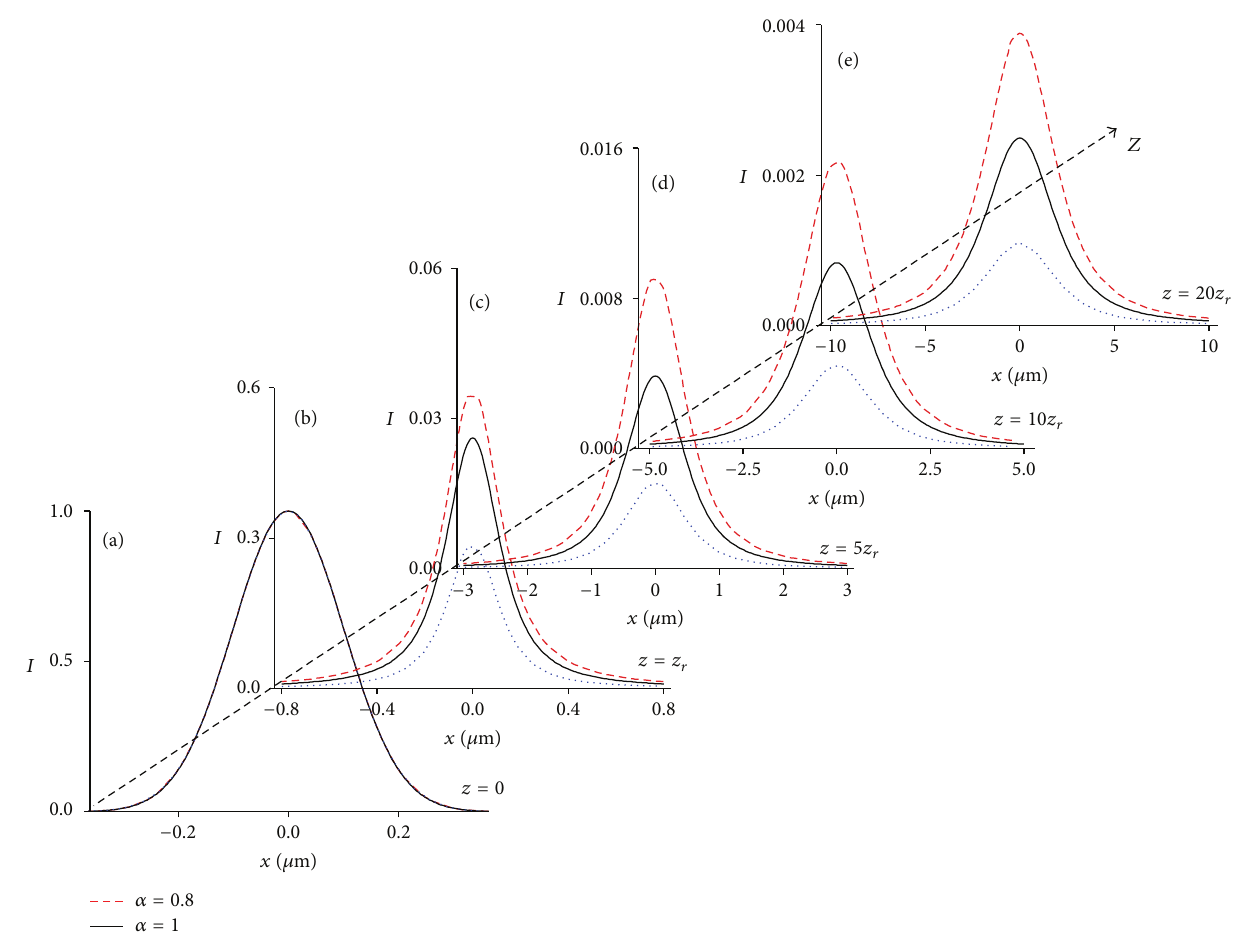
Figure 2: Intensity distribution of elliptical Gaussian beam for 𝑓 𝜔 = 0.5 as a function of 𝑥 in free space in different planes: (a) 𝑧 = 0 ; (b) 𝑧 = 5𝑧 𝑧 = 10𝑧 𝑧 = 20𝑧 𝑧 = 𝑧 𝑟 ; (c) 𝑟 ; (d) 𝑟 ; (e) 𝑟 . Several curves correspond to different elliptic coefficient curve); 𝛼 = 1.5 (dotted